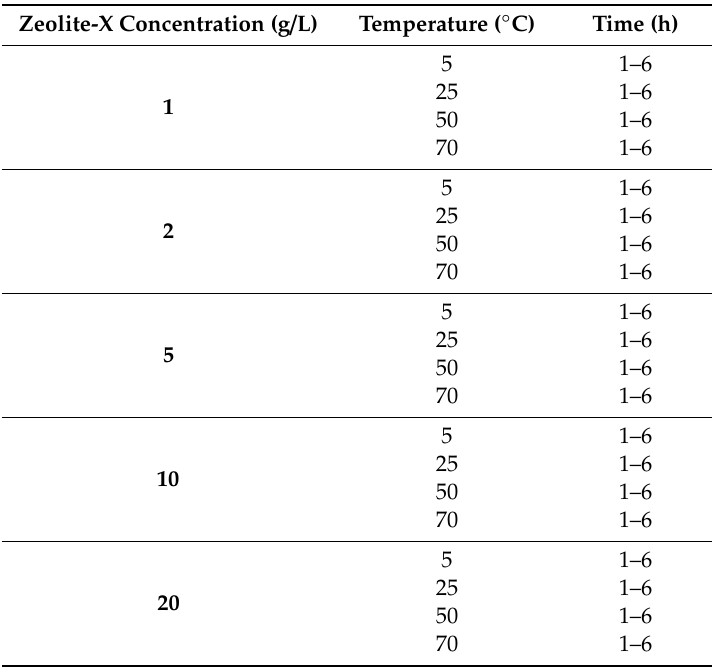
Table 4. The experimental protocol for measurements made for the treated solutions with zeolite-X based on the influence factors.